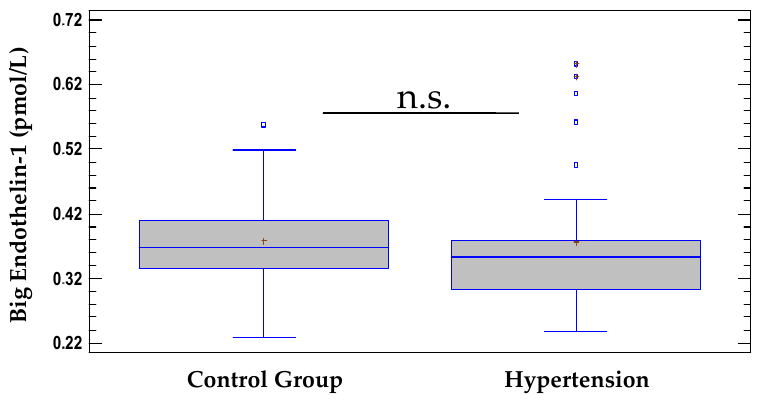
Figure 2. Serum levels of Big ET-1 in hypertensive group vs. control group. Data are represented as mean ± SD. n.s.—not significant ( p > 0.05).